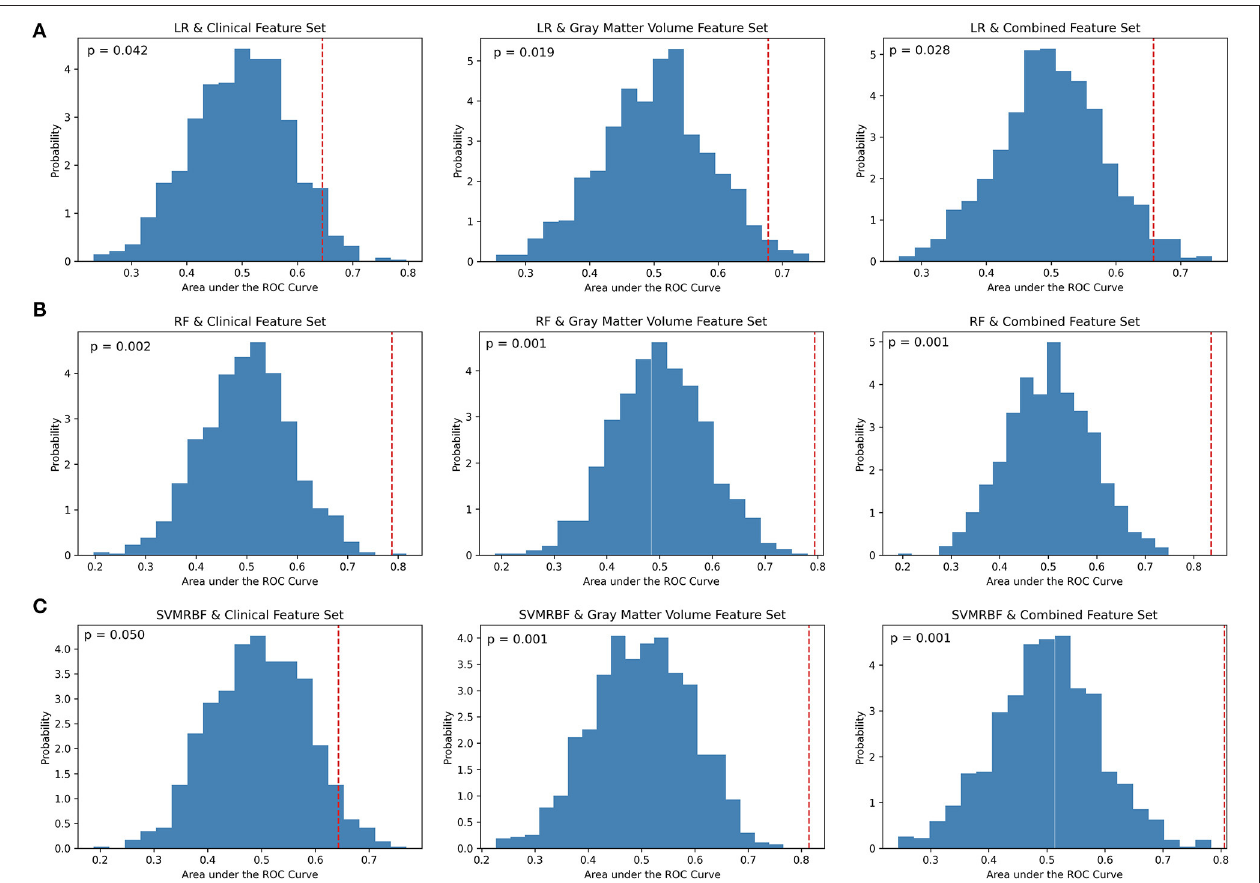
FIGURE 2 | Permutation analysis of cross-validation scores by classifier and feature set. (A) Logistic Regression (LR), (B) Random Forest (RF), and (C) Support Vector Machine-Radial Bias Function (SVMRBF) performance on 1,000 permuted datasets vs. true data was used to calculate the percentage of AUC scores occurring by chance ( p -value). A p < 0.01 determined significance. The dashed red line denotes the mean of AUC scores on the true data compared to the probability distribution of AUC scores calculated on the permuted